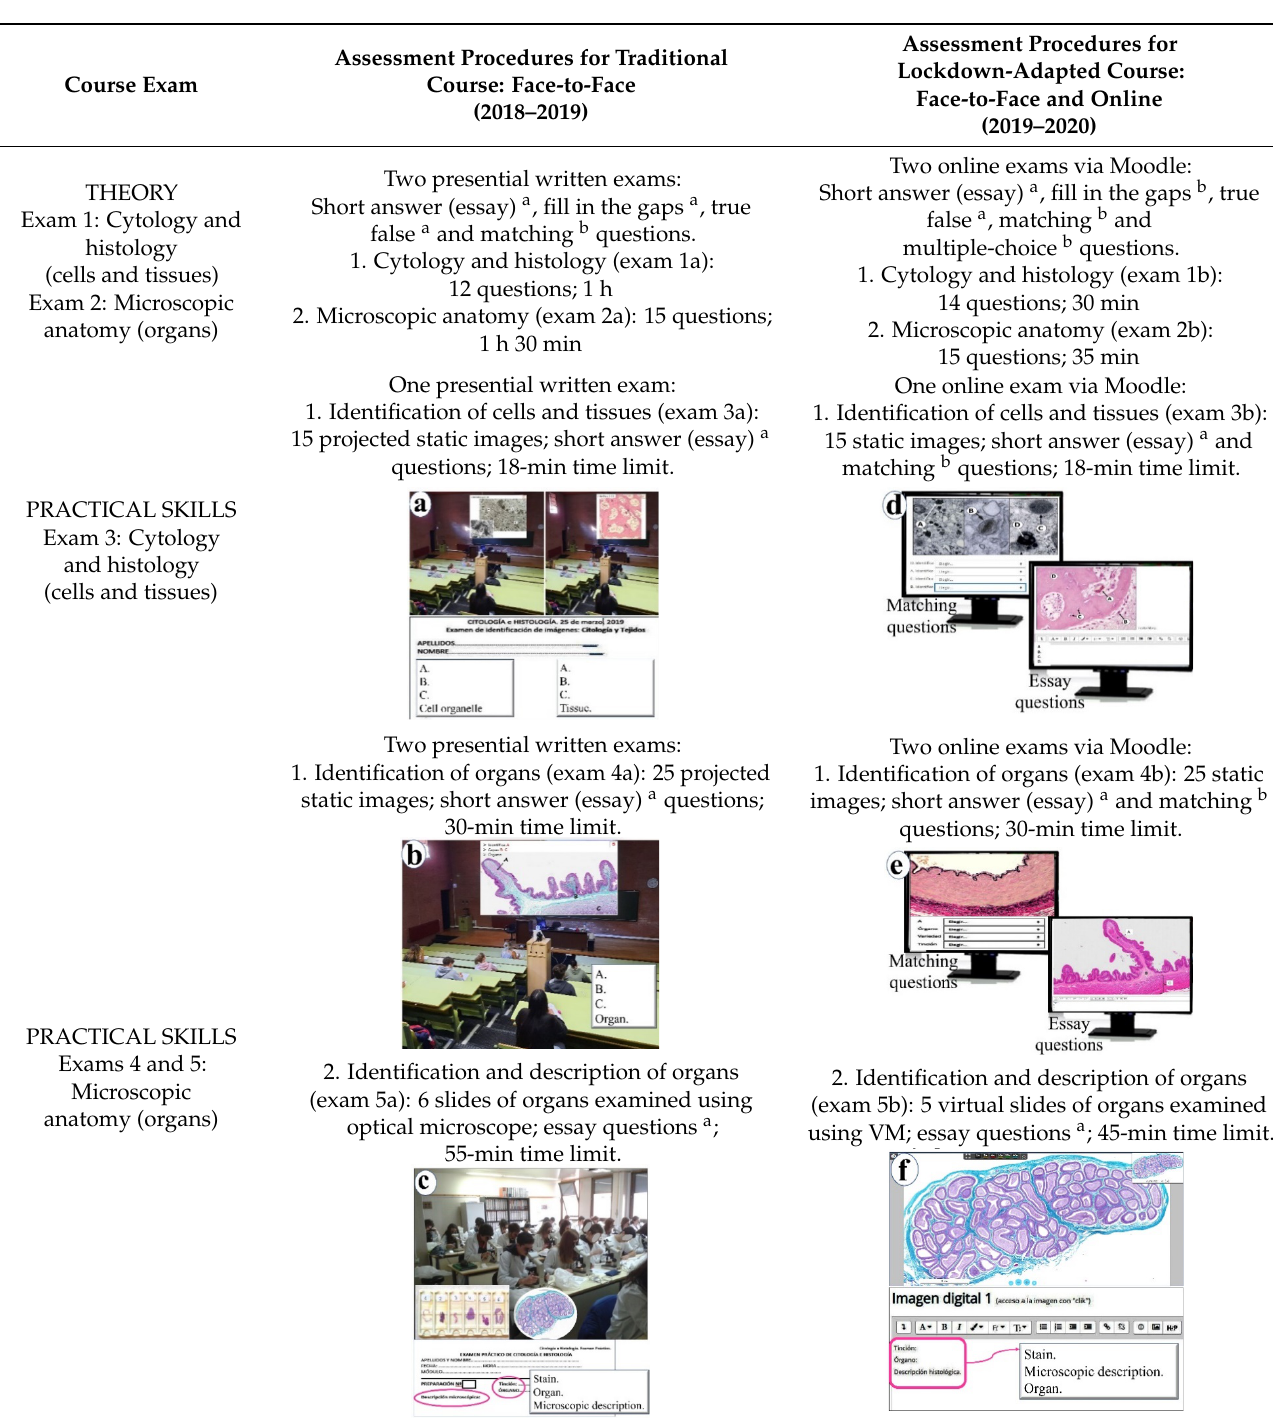
Table 2. Evaluation of students’ acquired theoretical and practical knowledge on cytology and histology: A description of evaluation methods used prior to (traditional course) and during the COVID-19 lockdown (lockdown-adapted course). Images from (a) to (f) show student evaluation methods used in both